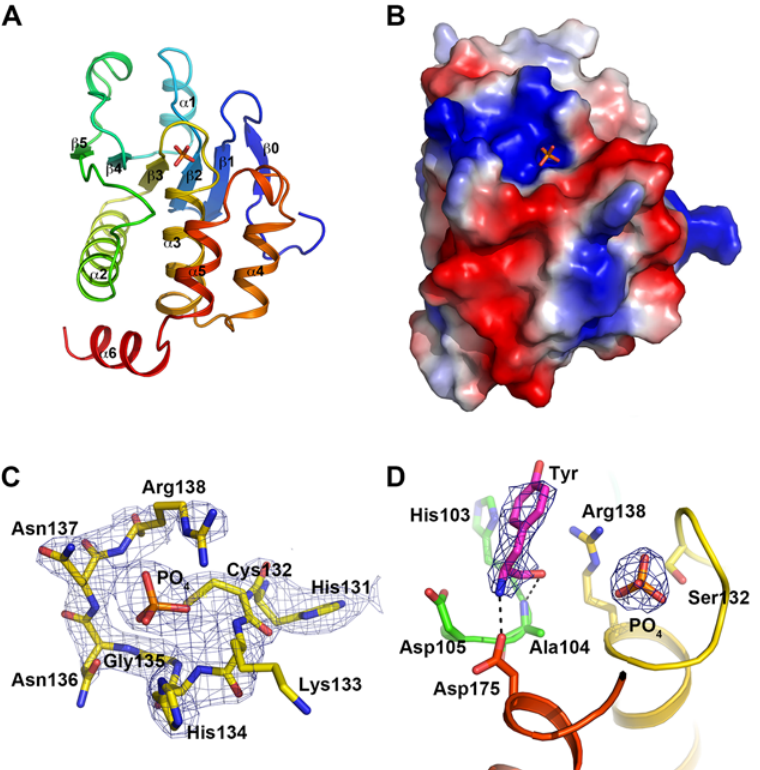
Fig 1. Crystal structure of P . aeruginosa TpbA. A: Cartoon representation of TpbA coloured from blue at the N-terminus to red at the C-terminus. Secondary structure elements are labelled and the phosphate ion is shown in stick representation. B: Electrostatic surface representation of TpbA. C: The PTP loop (residues 131 – 138) and phosphate ion are shown in stick representation. A 2mFo-DFc electron density map is shown contoured at 1.2 σ . D: 2mFo-DFc electron density for the orthophosphate and bound tyrosine from the Tpb (C132S) — pTyr structure. Electron density is shown contoured at 1.2 σ